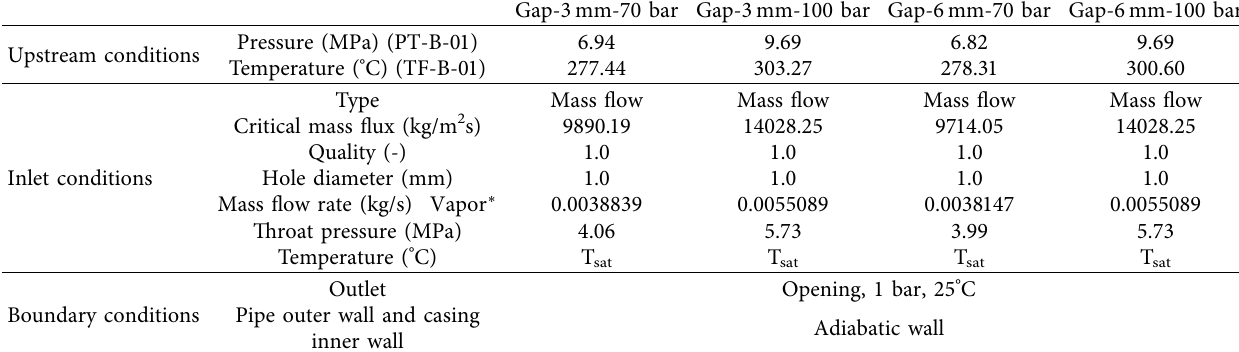
Table 2: Analysis